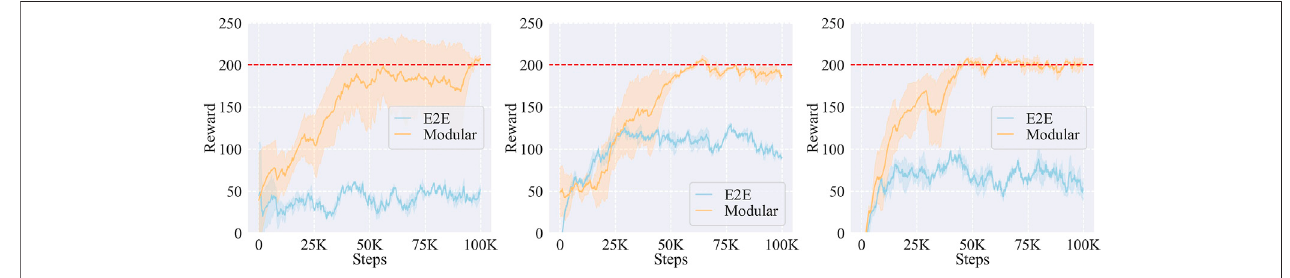
FIGURE 14 | Effects of the modular learning and the end-to-end (E2E) learning on the learning performance of A (2) (left) , A (3) (middle) , and A (4) (right)